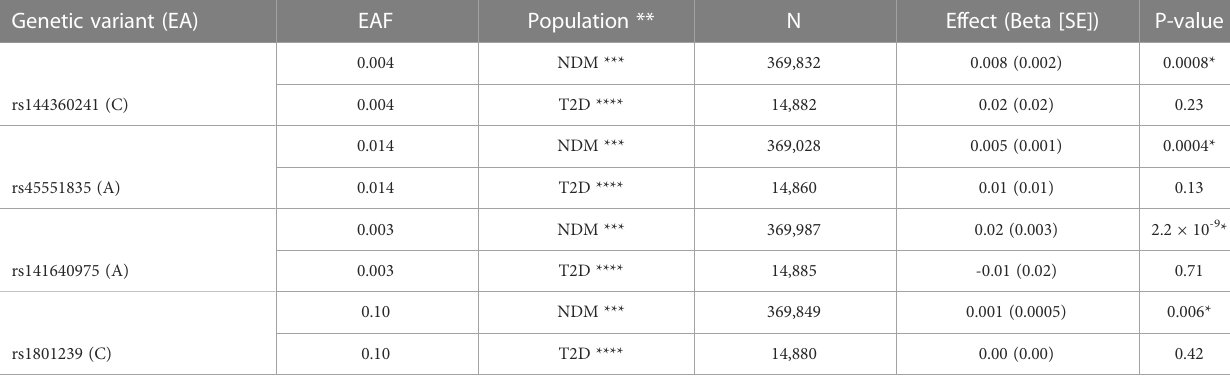
TABLE 4 Summary results for SNV-eGFR creatinine analyses in UKBB (model 1). Genetic variant